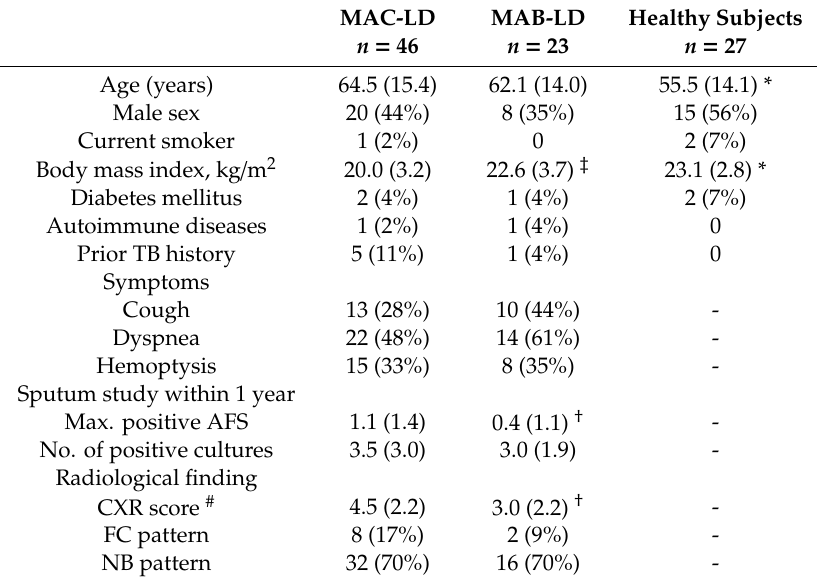
Table 1. Clinical characteristics of the